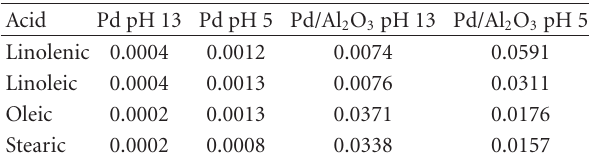
Table 1: Henry constants of linolenic, linoleic, oleic, and stearic acids in ethanol/water 70/30 at di ff erent pH (13 and 5) on di ff erent